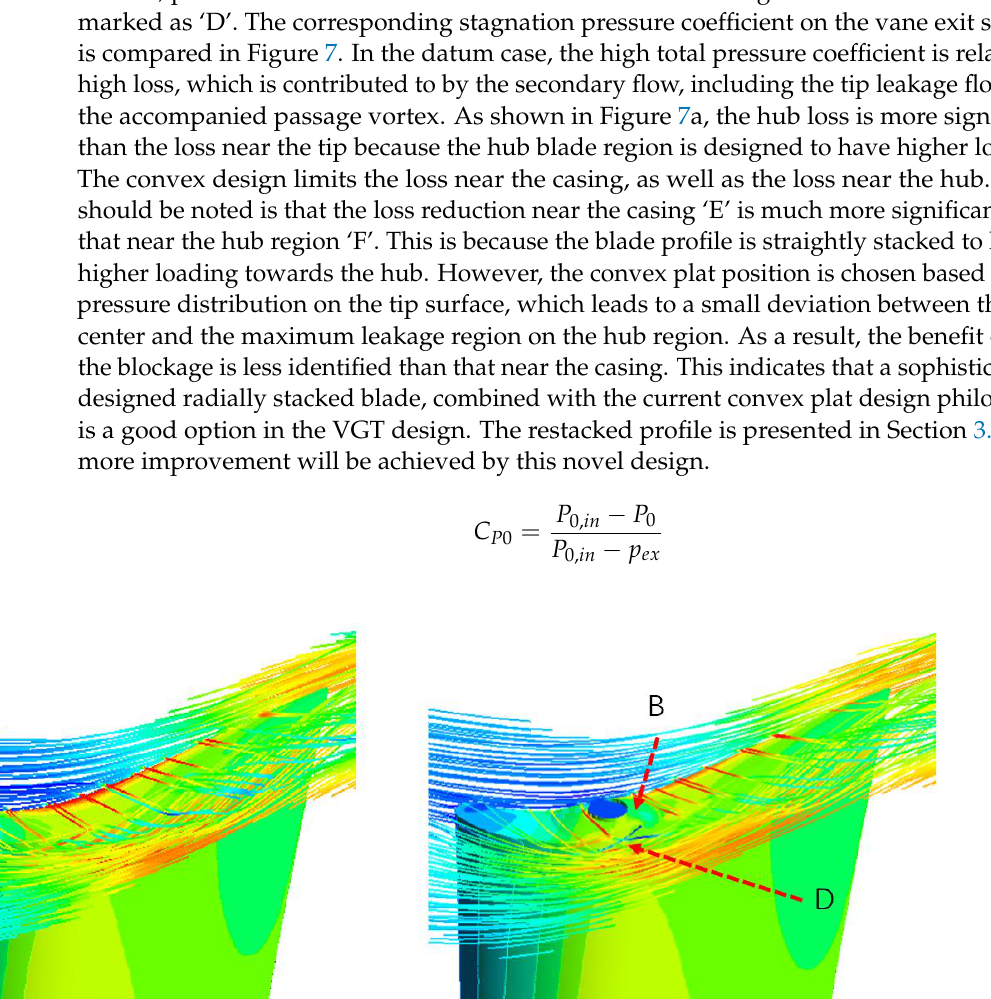
Figure 5. The cp distribution on the vane surface at design angle. ( a ) Datum ( b ) Convex.